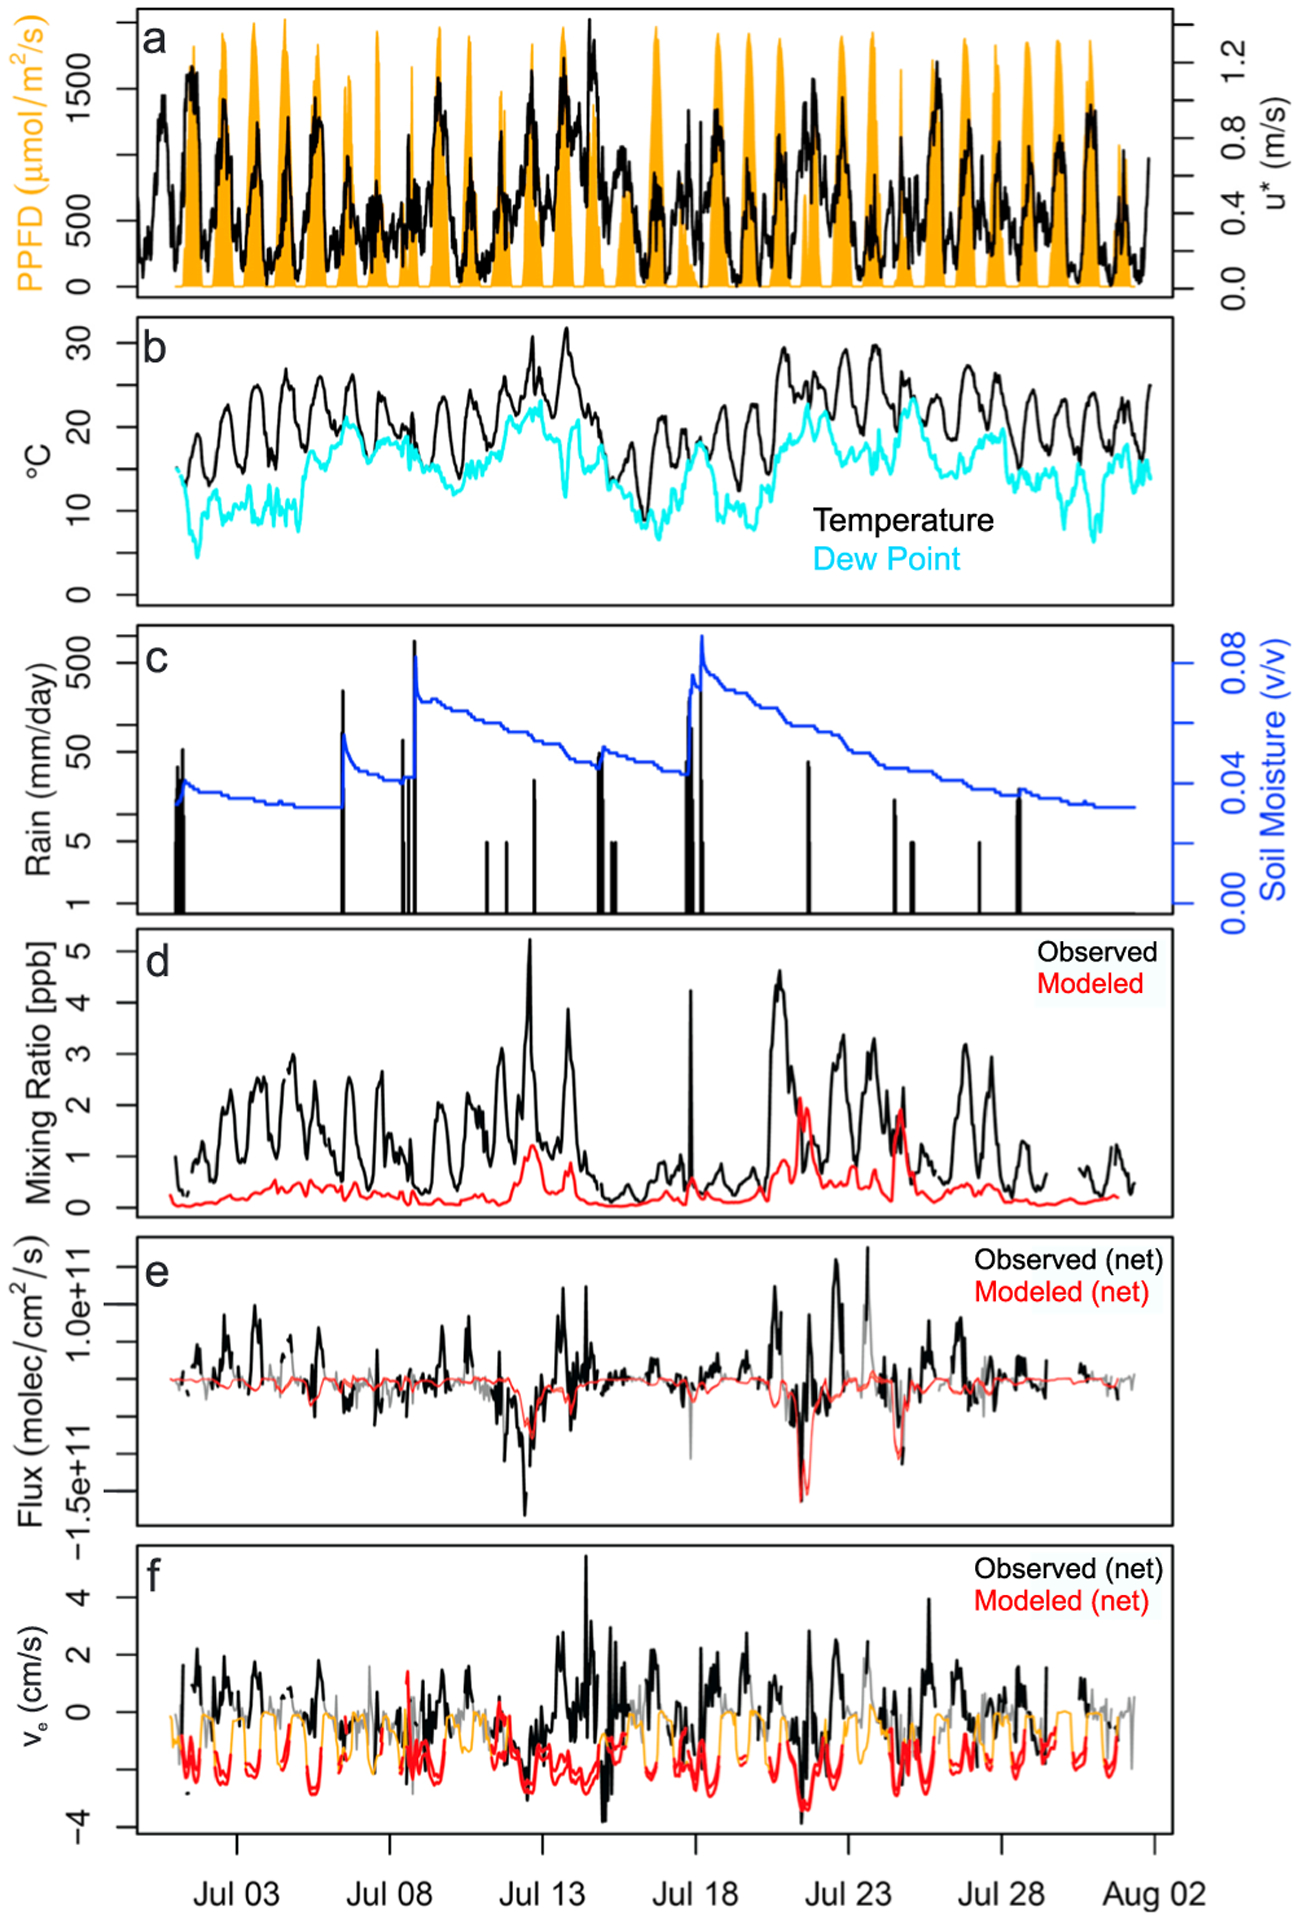
Time series of HCOOH and related measurements during PROPHET-AMOS. Plotted is the observed (a) photosynthetic photon flux density (PPFD) and friction velocity (u*), (b) temperature and dew point, (c) rainfall and soil moisture, (d) HCOOH mixing ratios, (e) net canopy HCOOH flux, and (f) net canopy HCOOH exchange velocity. Also shown in (d)–(f) are the simulated HCOOH mixing ratios, fluxes, and exchange velocities as predicted by GEOS-Chem (in red). For (e) and (f), the gray and orange lines show the full observational and model data sets, respectively, while the black and red show the same datasets after filtering for turbulent conditions (u* > 0.3 m/s).